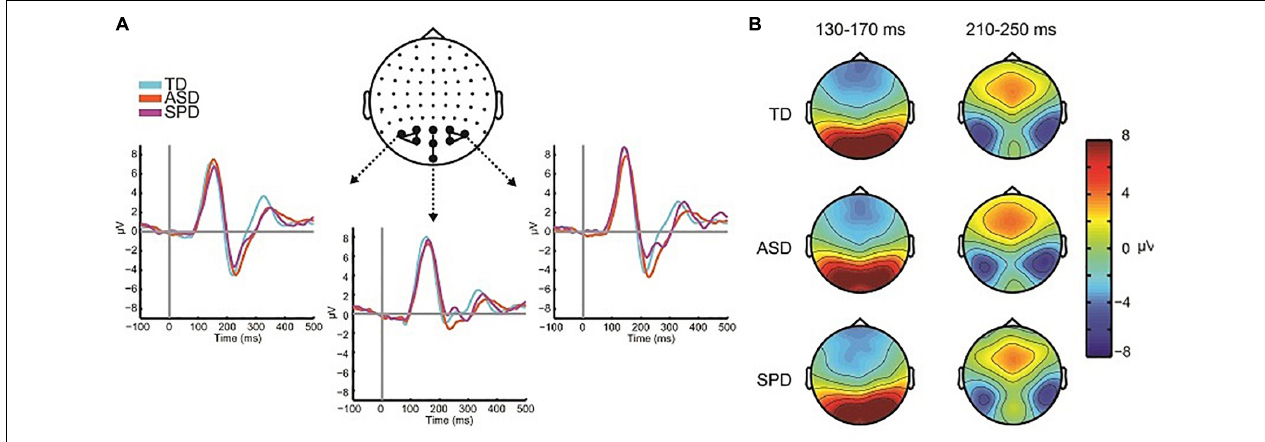
FIGURE 4 | Visual evoked potentials. (A) ERP waveforms in response to the visual alone condition over central and lateral occipital scalp regions for each of the three diagnostic groups. (B) Voltage topographies during temporal windows of interest for each diagnostic group.